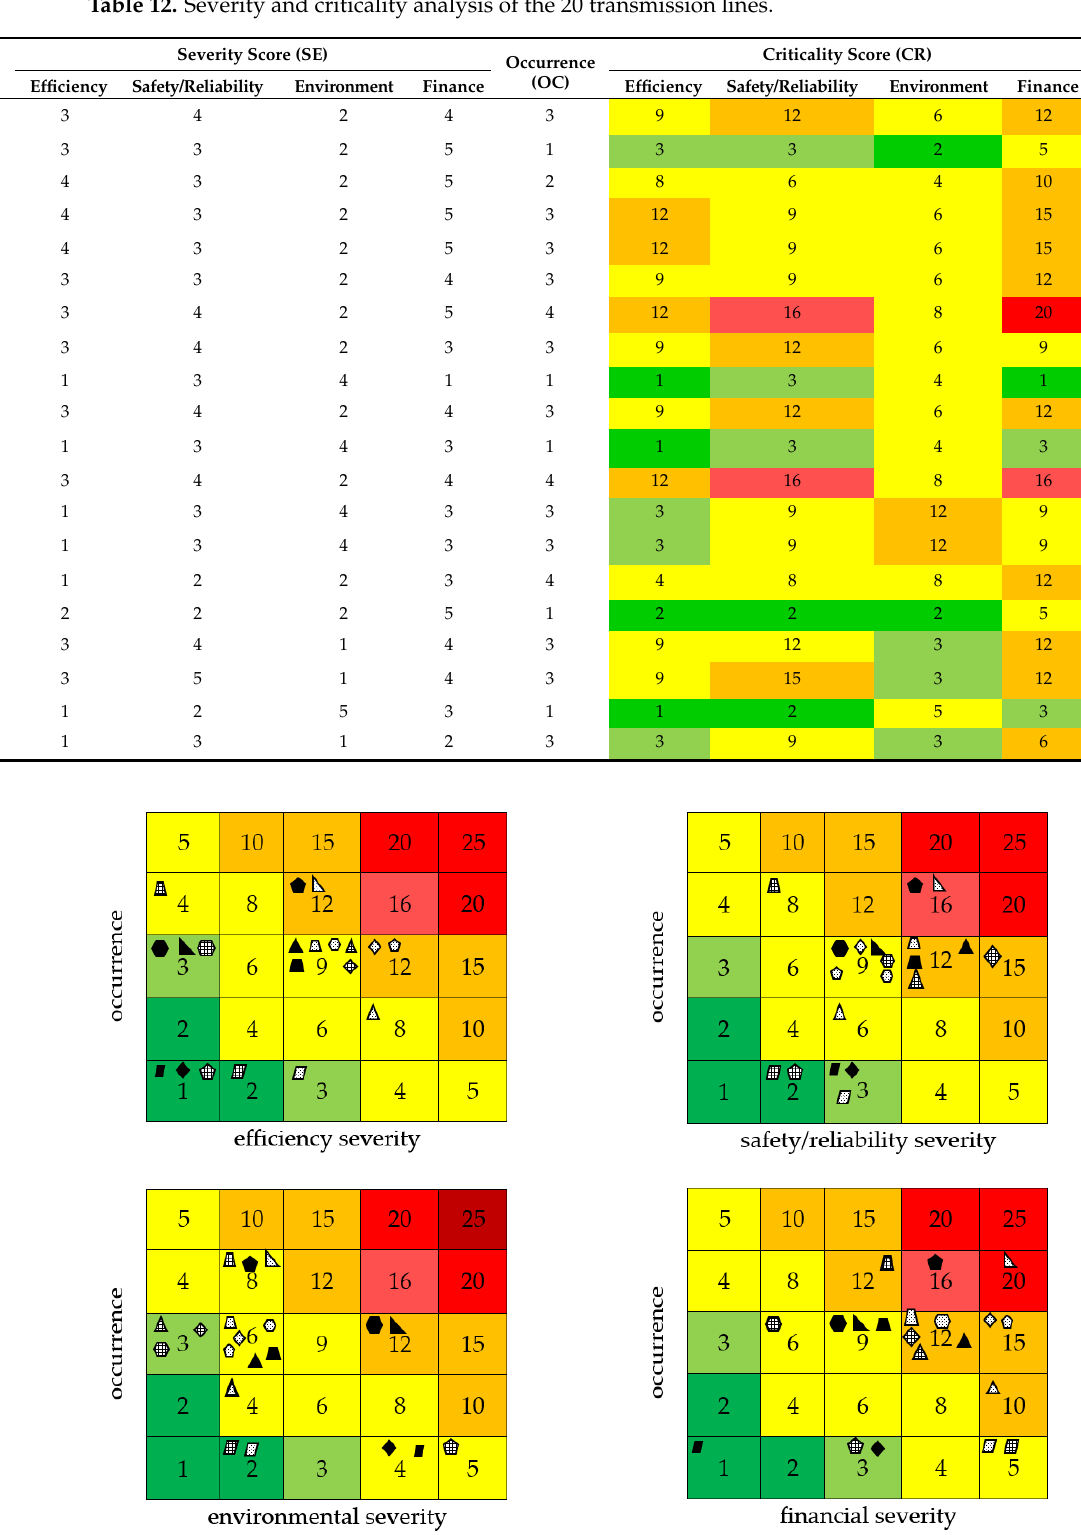
Figure 5. Criticality matrix of the sample 20 transmission lines. Table 13. Necessary data and analyzed scores of all sub-criteria for the transmission lines. Severity